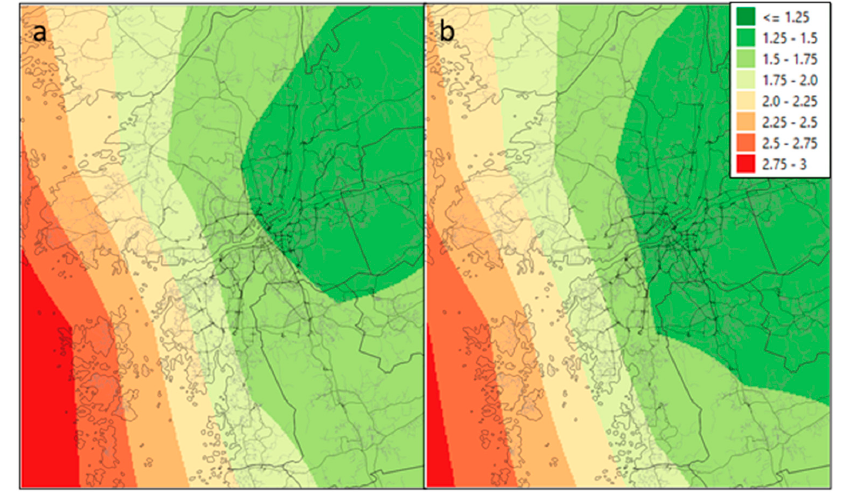
Figure 2. Exposure to PM 2.5 (µg/m 3 ) from shipping in the Baltic Sea in Gothenburg using a city-scale model: ( a ) high-sulfur; ( b ) low-sulfur. model: ( a ) high-sulfur; ( b ) low-sulfur. model: ( a ) high-sulfur; ( b ) low-sulfur.